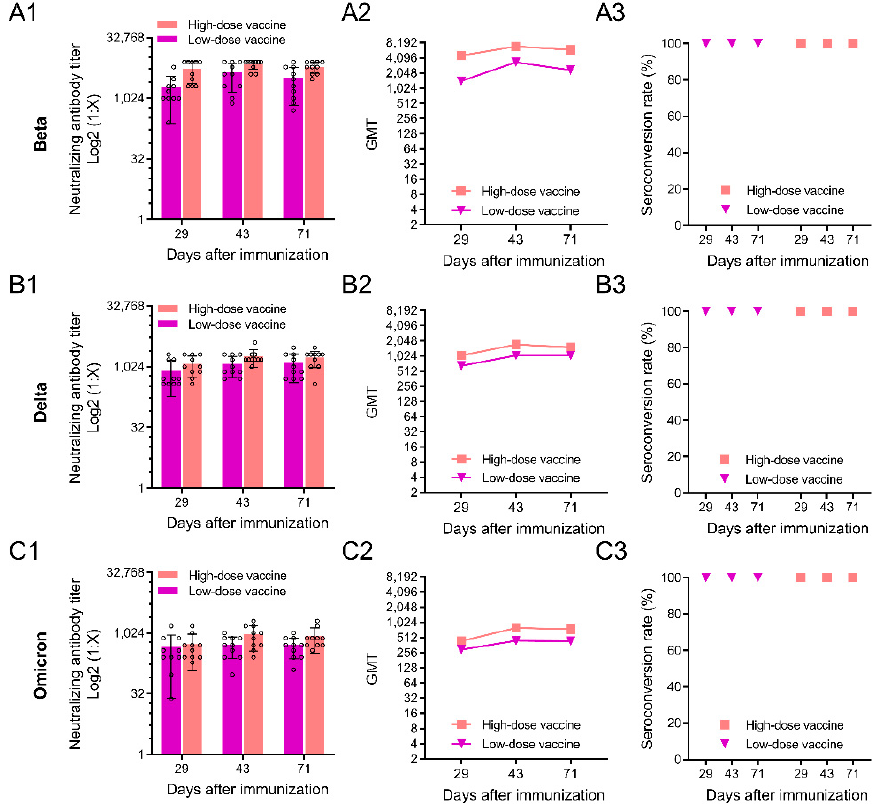
Figure 3. Results of neutralizing antibody responses against SARS-CoV-2 variants. ( A1 – A3 ), The neutralizing antibody levels against the Beta variant in serum and the GMTs of neutralizing antibodies and the seroconversion rates of neutralizing antibodies, respectively; ( B1 – B3 ) the neutralizing antibody levels against the Delta variant in serum and the GMTs of neutralizing antibodies and the seroconversion rates of neutralizing antibodies, respectively; ( C1 – C3 ) the neutralizing antibody levels against the Omicron variant in serum and the GMTs of neutralizing antibodies and the seroconversion rates of neutralizing antibodies, respectively. The data are presented as the means ± s.d ( n =10).